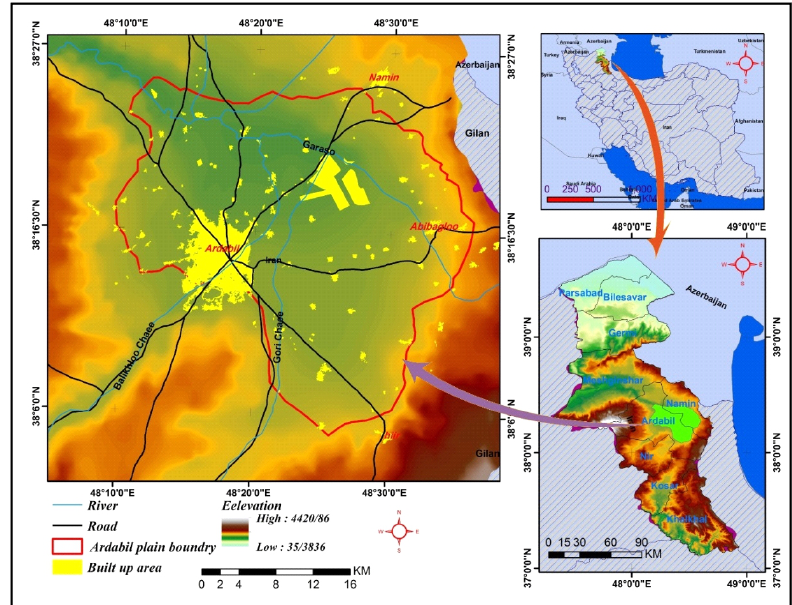
Fig. 1: Location of Ardabil